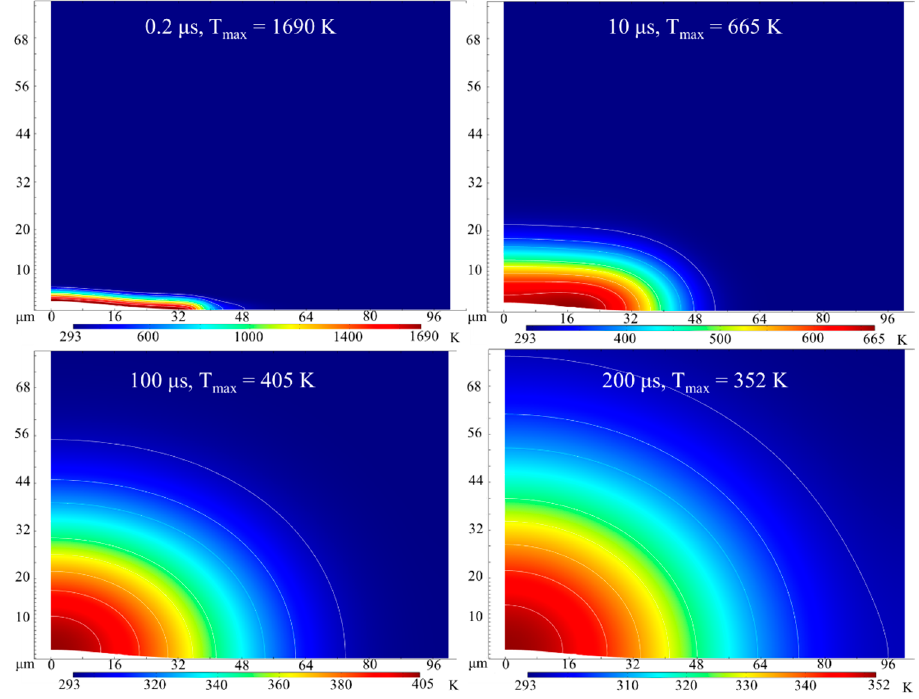
Figure 8. Evolution of simulated temperature distribution and heat-affected zone with time for laser fluence of 19.3 J/cm 2 .